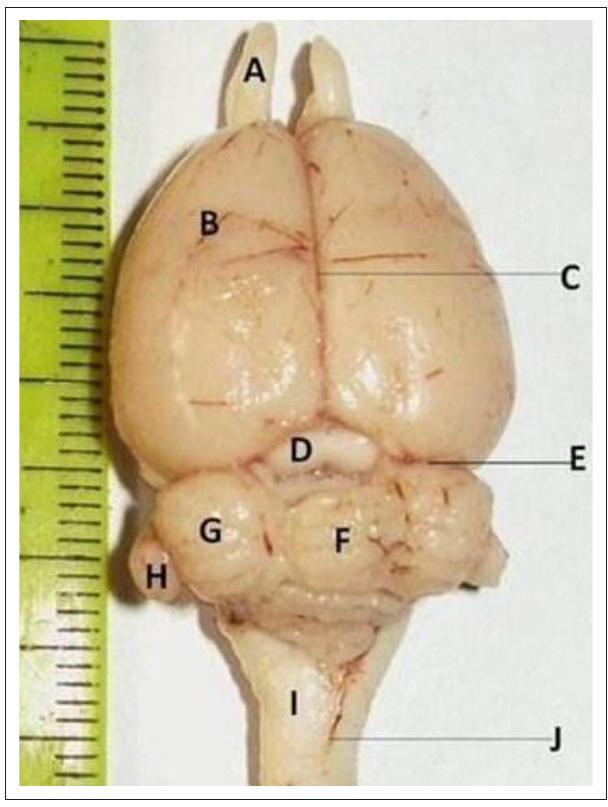
FIGURE 1: Dorsal view of the brain of the adult African giant pouched